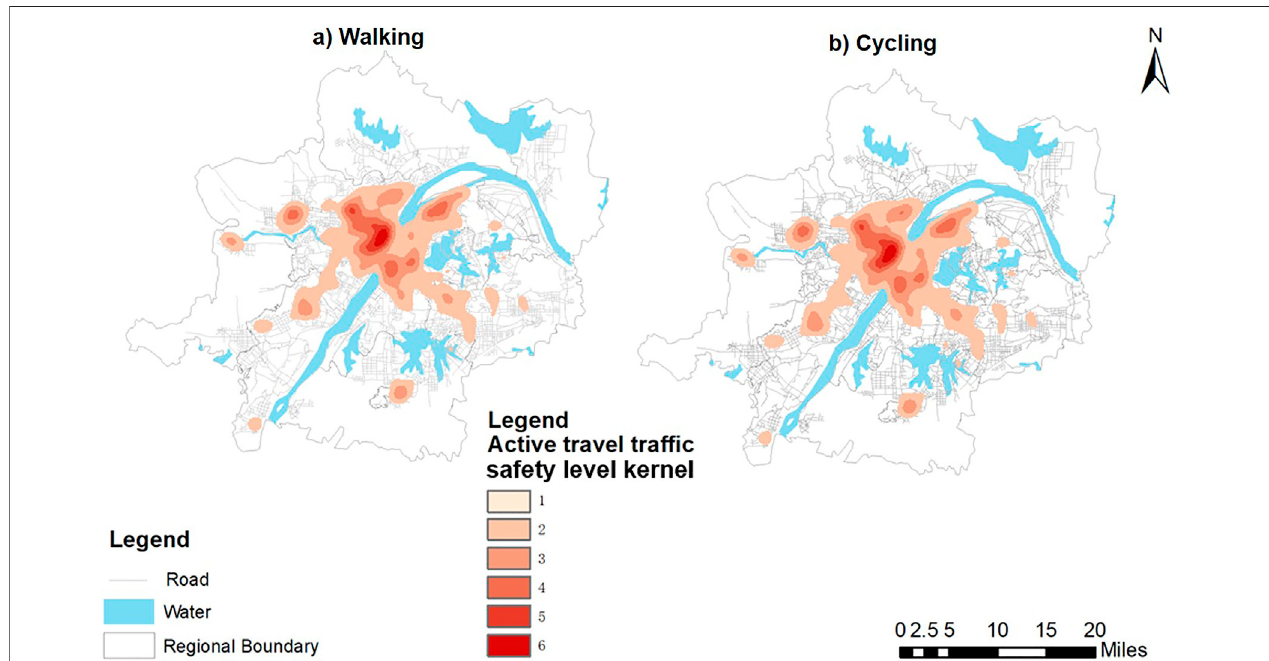
FIGURE 11 | ATTS clusters used in Wuhan.